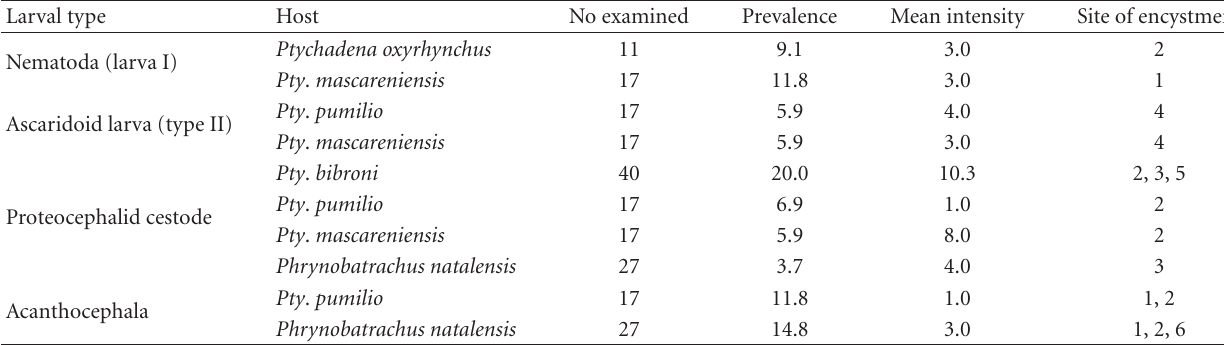
Table 3: Prevalence of larval helminthes in the anurans of Agbede.